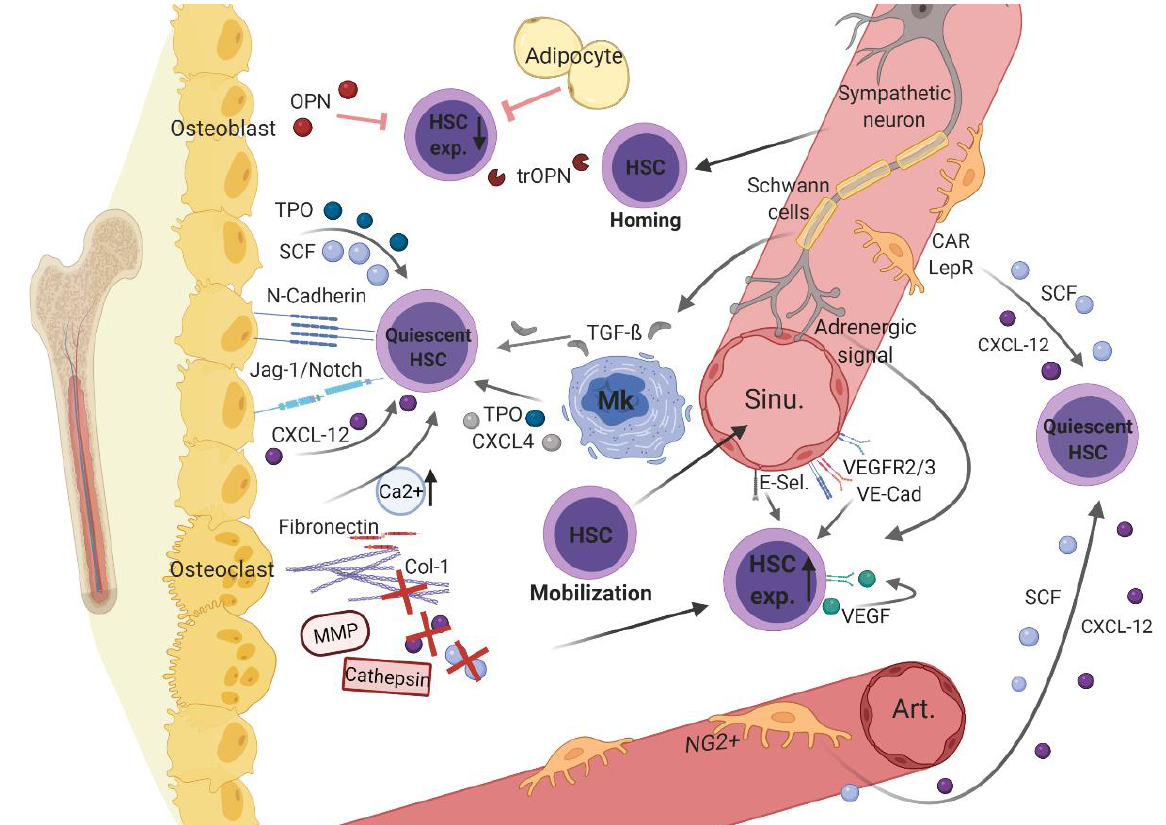
Figure 1. Healthy hematopoietic bone marrow microenvironment. Endosteal and vascular niches within the BMM consist of different hematopoietic cells (i.e., hematopoietic stem cell [HSCs] and megakaryocytes [MK]) as well as non-hematopoietic cells (e.g., osteoblasts, osteoclasts, adipocytes, sympathetic neurons with associated Schwann’s cells, distinct perivascular stromal cells [neural-glia-2 (NG2+)], C-X-C motif chemokine [CXCL]-12 abundant reticular [CAR] cells, leptin-receptor-positive [LepR+] cells, and endothelial cells) and structural components (i.e., arterioles [Art.], sinusoidal vessels [sinu.], fibronectin, collagen [Col]-1, calcium [Ca2+], and the enzymes cathepsin and matrix metalloproteinase [MMP]). Various non-cellular factors (e.g., osteopontin [OPN], thrombin cleaved OPN [trOPN], and stem cell factor [SCF)), C-X-C motif chemokine [CXCL]-12, CXCL-4, transforming growth factor beta [TGF- β ], vascular endothelial growth factor [VEGF], and vascular endothelial cadherin [VE-Cad], thrombopoietin [TPO], Notch, and its ligand Jagged-1) expressed by the cellular components contribute to hematopoietic regulation in the BMM. Figure 1 was created with biorender.com (accessed on 13 February 2021).